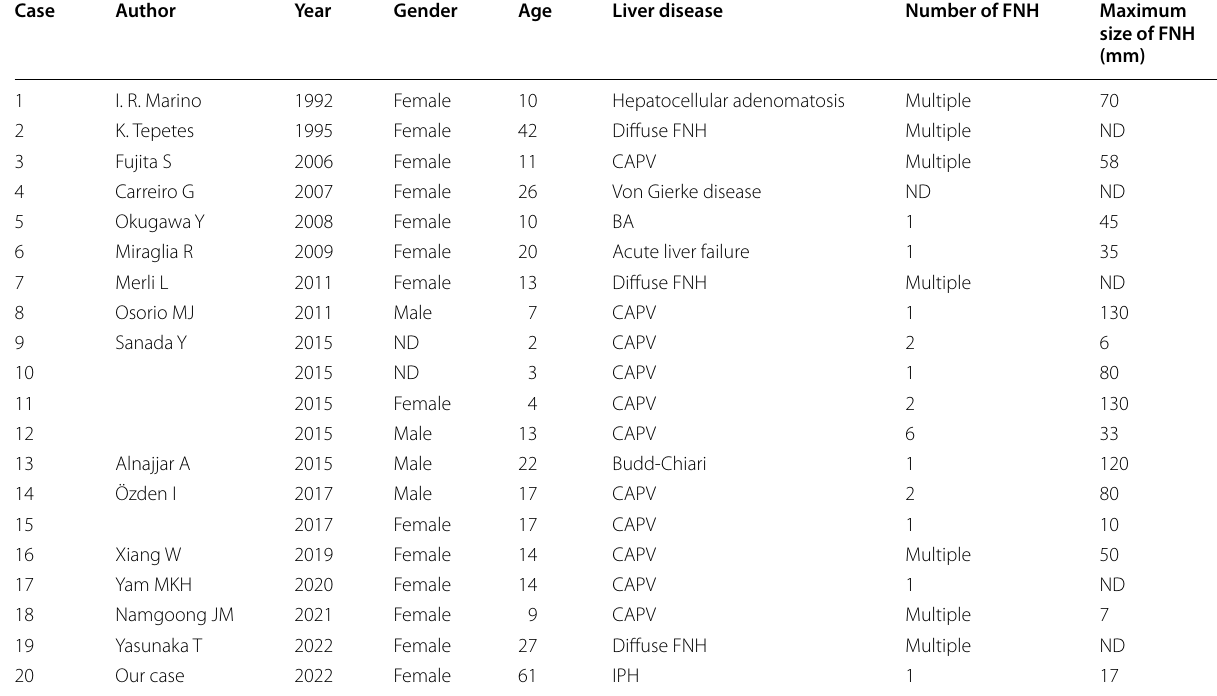
BA biliary atresia, CAPV congenital absence of the portal vein, FNH focal nodular hyperplasia, IPH idiopathic portal